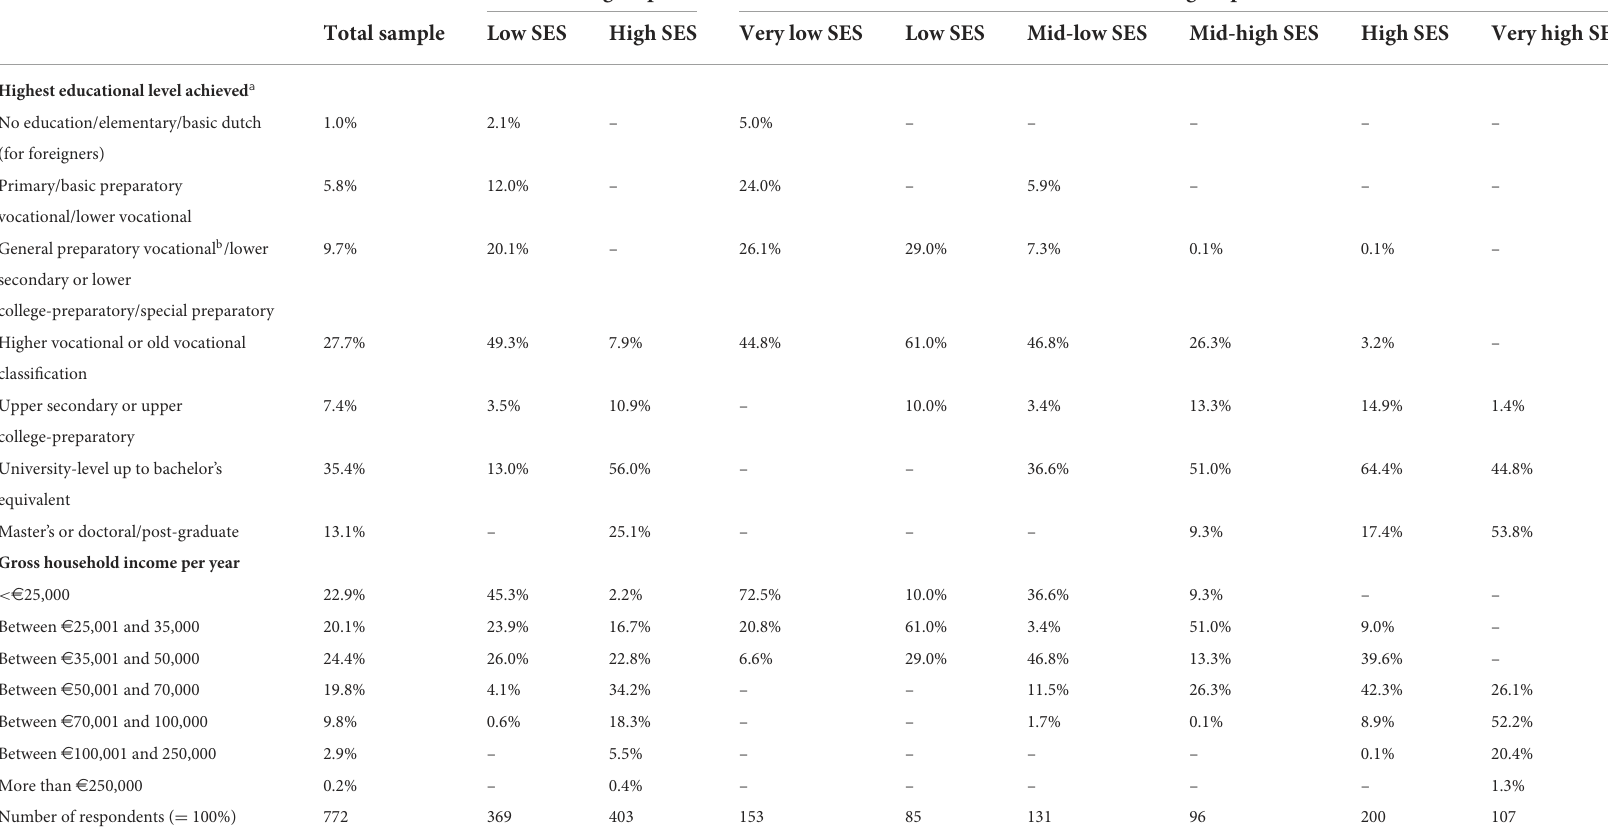
TABLE 1 Sample and SES groups’ composition based on education and